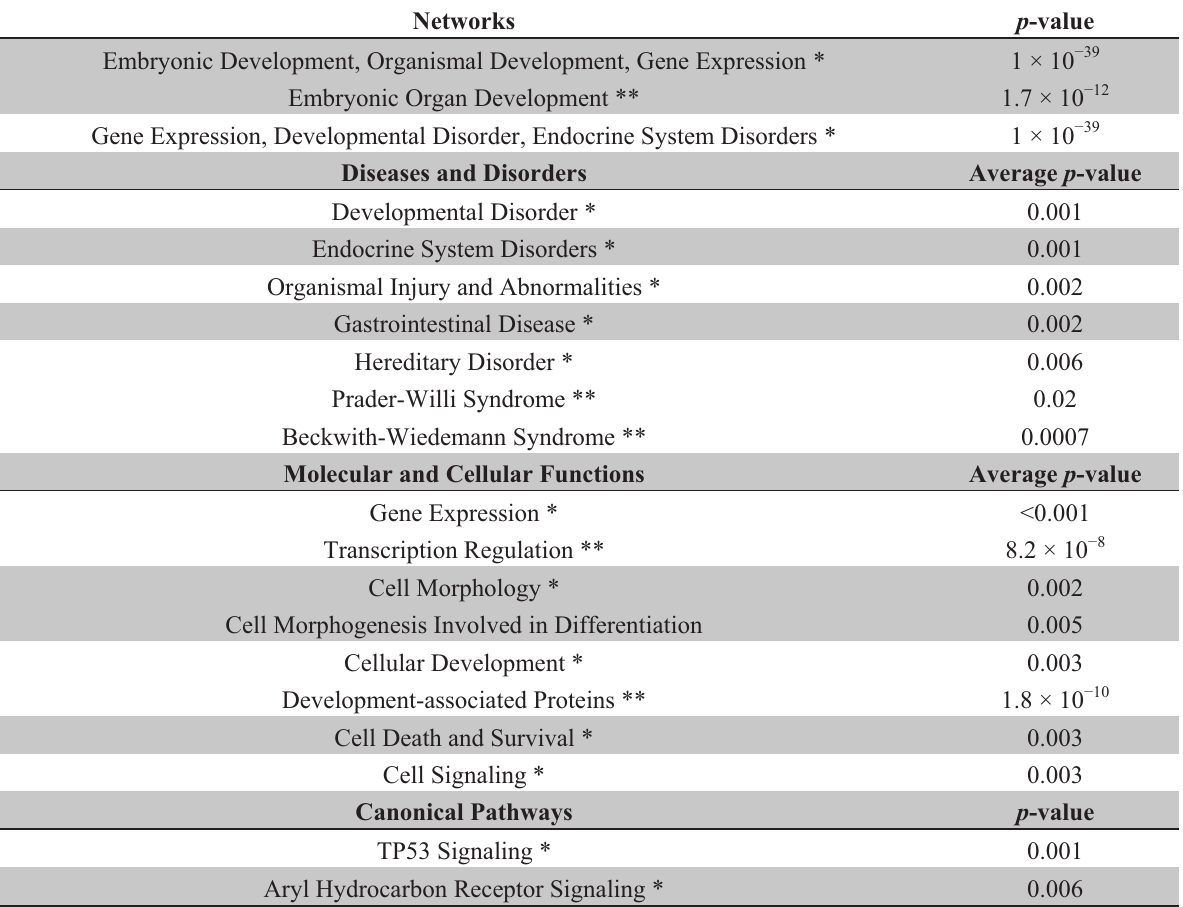
Table 1. Summary of enriched biological processes/functions of the imprinted gene set. Networks Embryonic Development, Organismal Development, Gene Expression